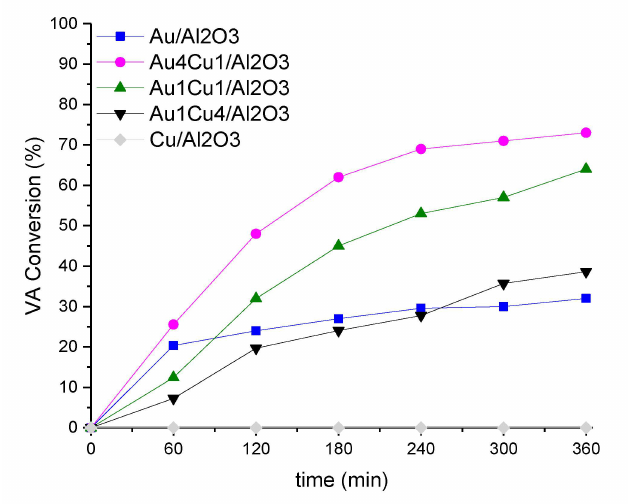
Figure 9. VA conversion as a function of reaction time by Au- and Au-Cu supported on alumina. Reaction conditions: 80 ◦ C, 2 bar of O 2 , VA 0.15 M in p-xylene, VA: metal molar ration